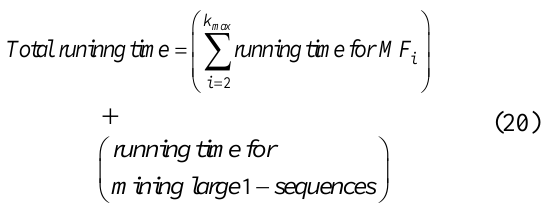
Figure 16. Relationship between the number of large 1-sequences and different minimum